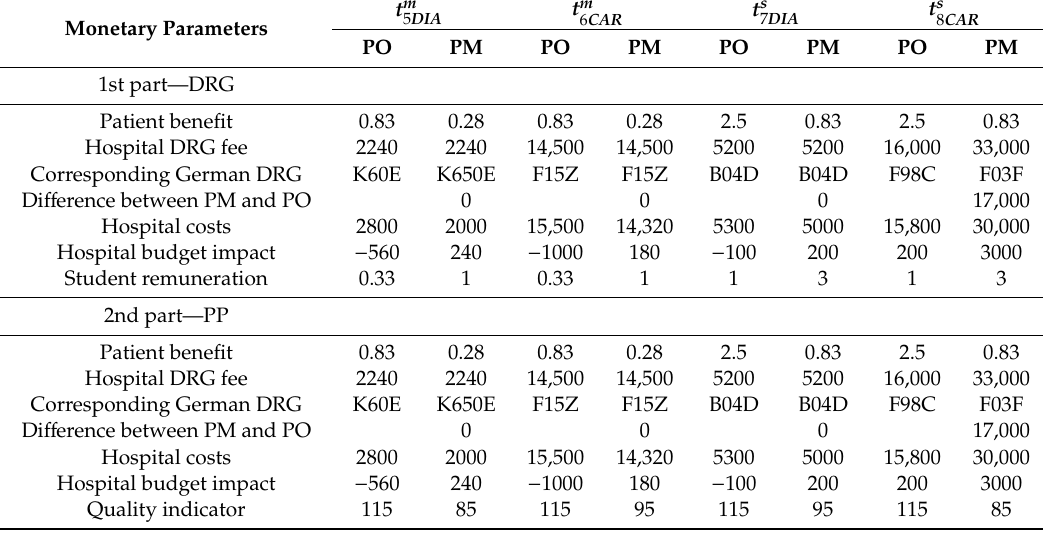
Table A6. Monetary Parameters for Medical Students w Patient Benefit—Treatment Cases 5–8. Monetary Parameters